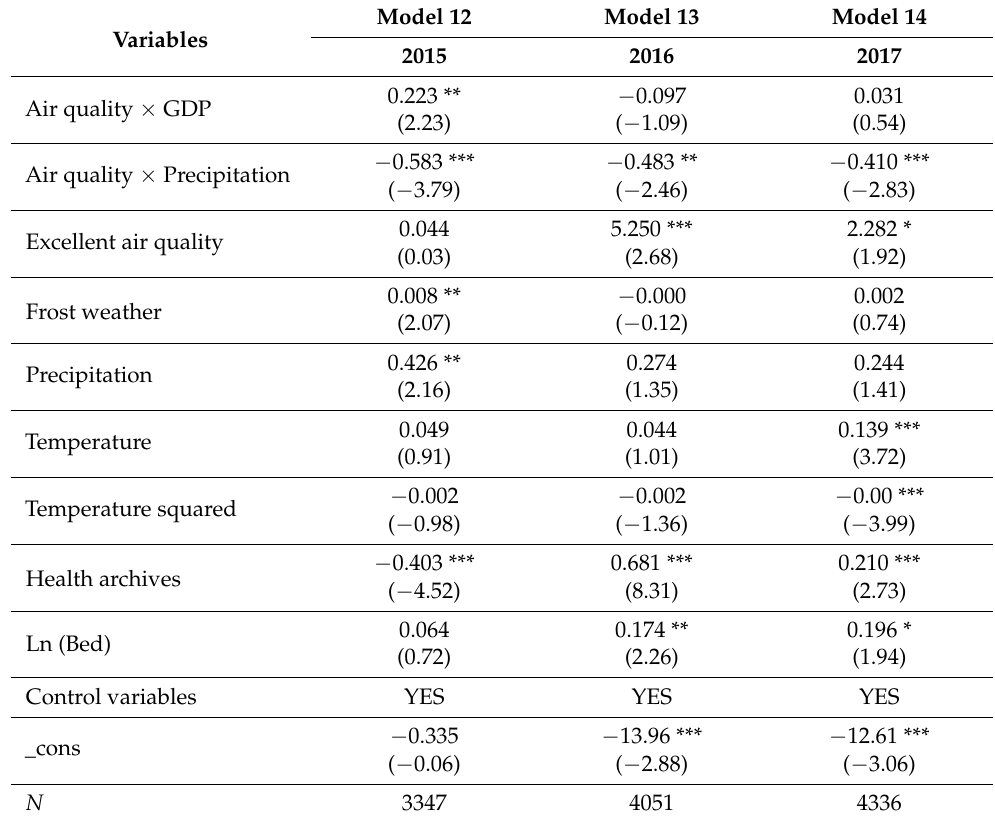
Table 6. The dynamic results of natural amenity and elderly migrants’ settlement